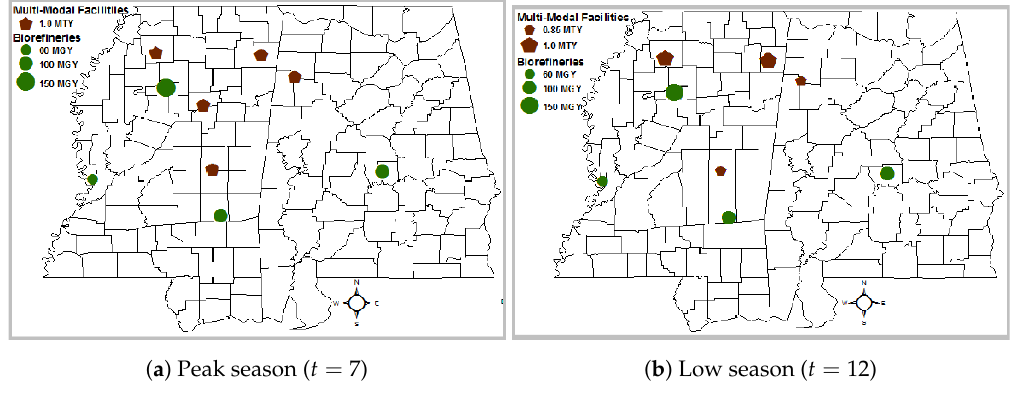
Figure 7. Network representation under risk averse scenario.